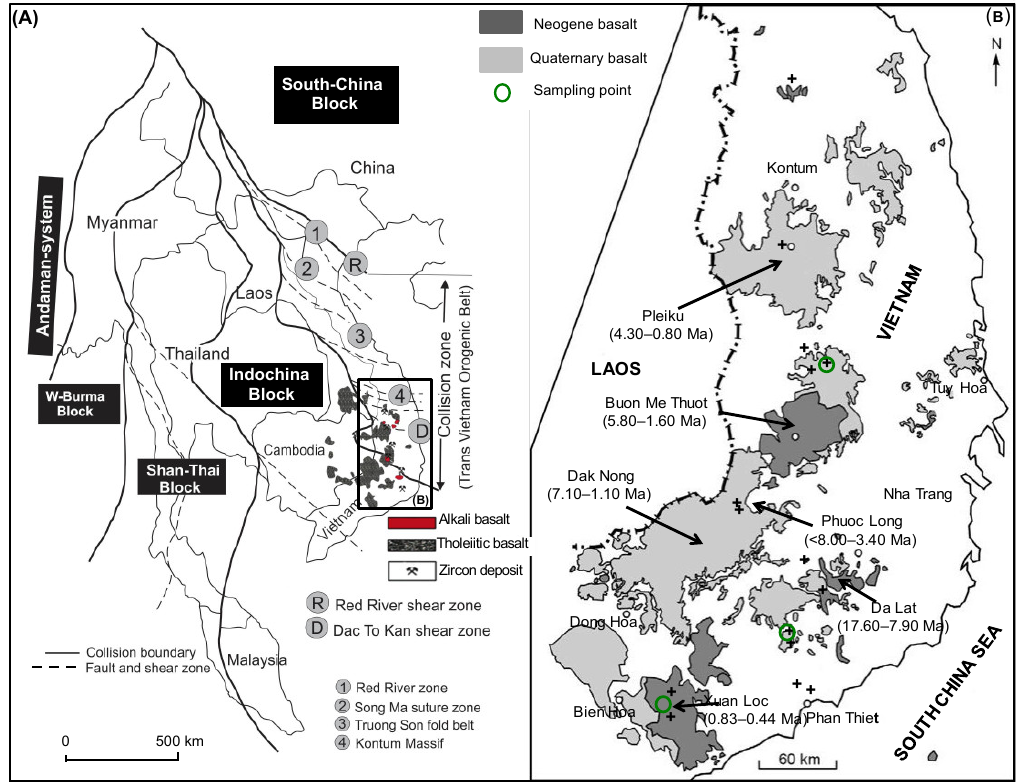
Figure 1. ( A ) Location of various alluvial zircon deposits in Cambodia and Vietnam within South-East Asia [12,24]. ( B ) Distribution of Neogene and Quaternary basalts with their K-Ar and Ar-Ar ages (after [4,6]). Reproduced with permission from all authors. Green circles indicate the sampling localities.